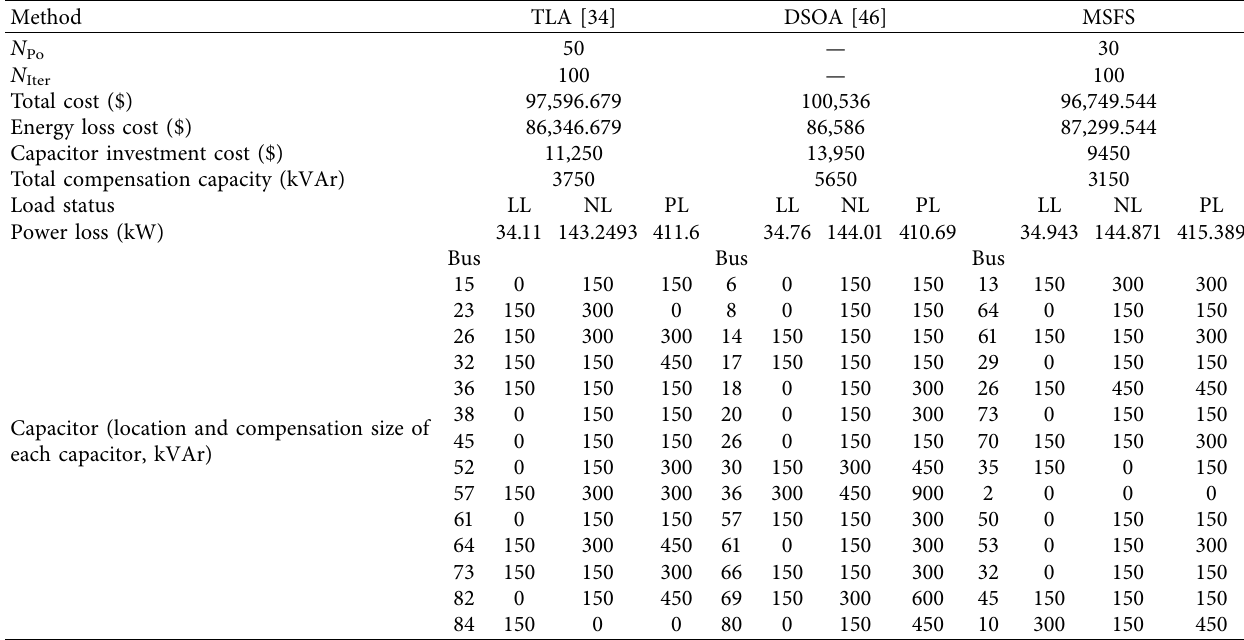
Table 14: Comparisons of result obtained by MSFS and other methods for the 69-bus system with the objective function of total cost.